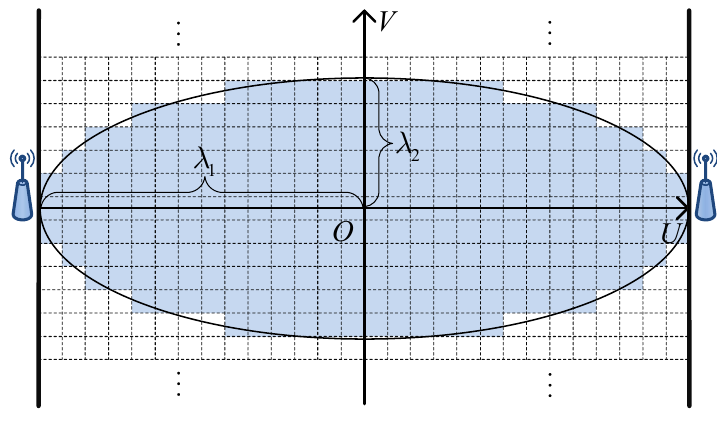
Figure 2. Spatial impact area of a wireless